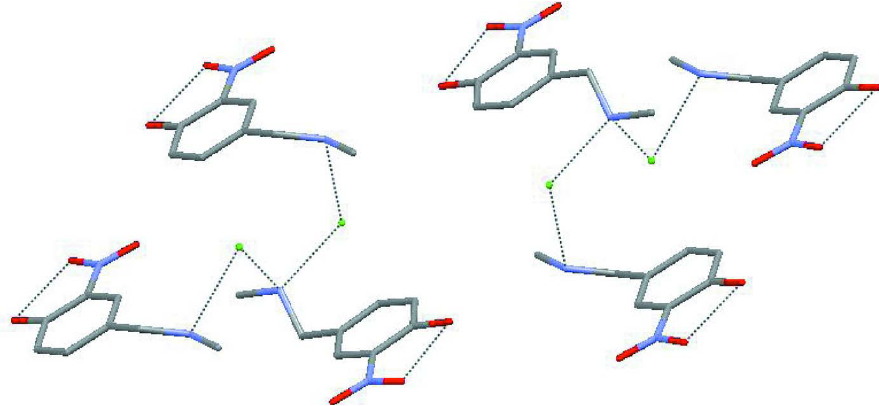
Figure 2 Diagram of the inter- and intramolecular hydrogen bonding. Hydrogen atoms have been omitted for